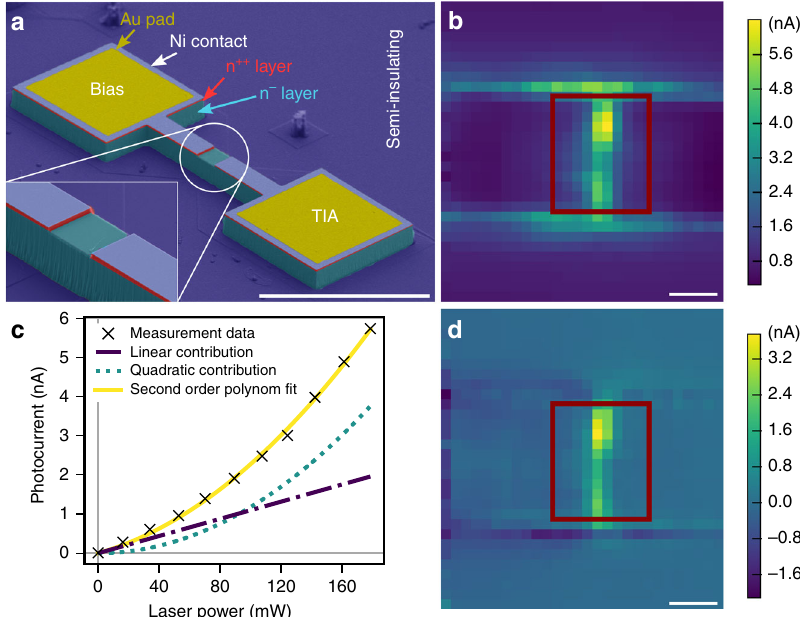
Fig. 2 Sample and photocurrent imaging. a SEM picture (functional layers false color coded) of a fabricated device. Bias and transimpedance ampli fi er (TIA) connections are marked. Inset: Zoom-in of the etched optical opening. Scale bar: 100 µ m. b Photocurrent map at − 10 V bias. Approximate position of optical access opening marked in red. Scale bar: 5 µ m. c Laser power dependence of the photocurrent at the position of maximum two-photon contribution corresponding to a bright spot in panel d . Fit f ð x Þ ¼ ax 2 þ bx separates linear and quadratic contributions, where x stands for optical power. Fit parameters are: a = 117.77 ± 6.43 fA mW − 2 , b = 10.96 ± 0.93 pA mW − 1 . Black crosses denote measurement points, yellow solid line fi t f ð x Þ . Purple dashed-dotted line shows linear and green dotted line quadratic contribution. d Map of two-photon excitation contribution to photocurrent at maximum laser power obtained via fi t parameter a . Scale bar: 5 µ